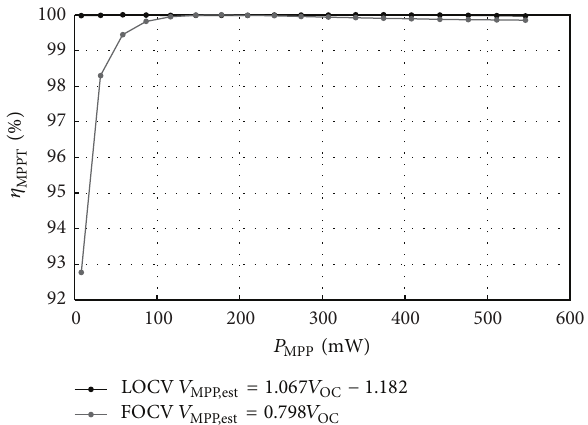
Figure 10: 𝑉 versus 𝑉 for a 500 mW panel simulator at 𝑇 MPP OC 25 ∘ C and two fitted least-square regression lines corresponding to the FOCV and LOCV methods.